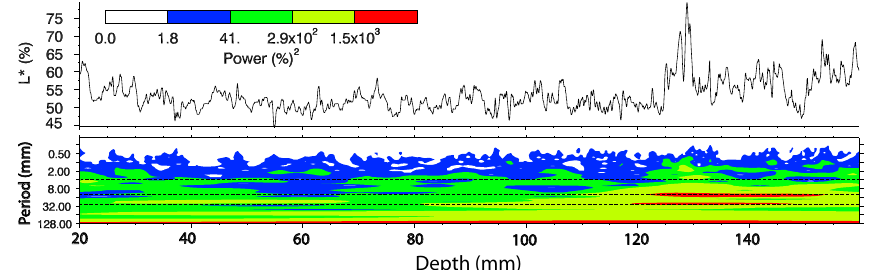
Figure 6. Wavelet power spectrum of lightness values in a laminated portion of core SN ◦ 4 (Section 41, Segment 1). Morlet wavelet with 6 parameters, the contour levels are chosen so that 75, 50, 25, and 5% of the wavelet power is above each level, respectively (Torrence and Compo,